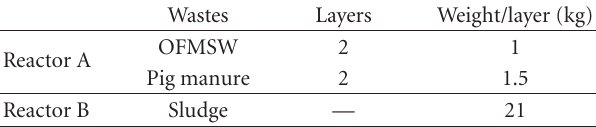
Table 1: Composition of the modified SEBAC reactors. Wastes Layers